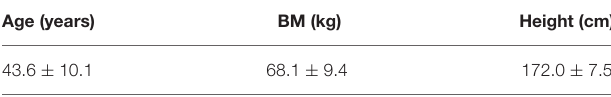
TABLE 1 | Anthropometric parameters of divers involved in the study. Age